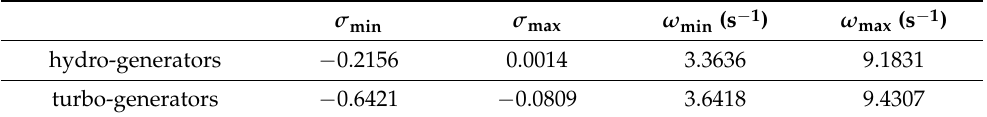
Table 6. The boundaries of real and imaginary parts of local mode eigenvalues of hydro and turbo synchronous generators with AVR systems of different nominal powers in the range P = 0.0 pu to P = 1.0 pu and from Q = 0.0 pu to Q = 1.0 pu. σ min σ max ω min (s − 1 ) ω max (s − 1 )